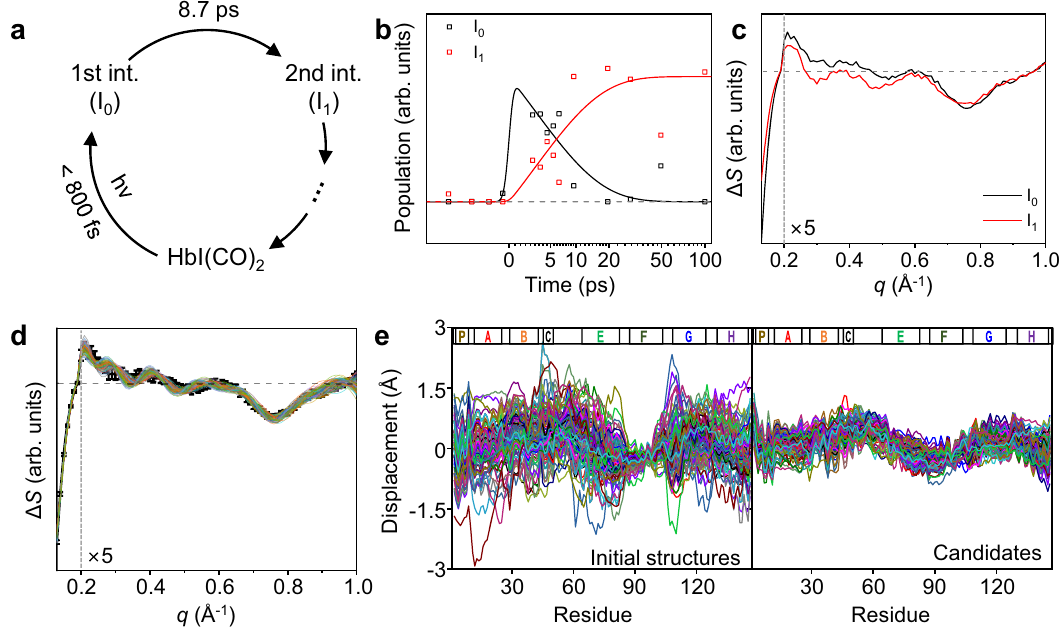
Fig. 2 Kinetic analysis and structure re fi nement for intermediates of HbI. a A kinetic model for the initial response of HbI(CO) 2 upon photoexcitation. The fi rst reaction intermediate (I 0 ) forms within the instrument response function (800 fs) and transforms into the second reaction intermediate (I 1 ) with a time constant of 8.7 ps. b Relative population pro fi les of I 0 and I 1 calculated based on the sequential kinetic model (black and red lines). Optimized populations of each reaction intermediate at each time delay are marked with open squares. c SADSs of I 0 and I 1 . The SADSs were calculated by taking a linear combination of the fi rst and second left singular vectors (lSVs) of SVD results. For clarity, the high q region with q ≥ 0.2 Å − 1 is scaled up by 5. d The SADS of I 0 (black) and the theoretical difference scattering curves of 108 candidates (other colors). For clarity, the high q region with q ≥ 0.2 Å − 1 is scaled up by 5. e Displacement plots of initial structures used for the ERRB structure re fi nement aided by MC simulations (left) and candidate structures obtained from the structure re fi nement (right). For each subunit, the displacement was calculated as the changes in the distance from the iron atom to the C α atom of each residue with respect to the carboxy structure. The displacements of the same residues in the two subunits were averaged. For the displacement plots of the initial structures, 108 initial structures were selected randomly out of the total 270 initial structures used for the structure re fi nement. The labels of the helices are shown at the top of the plots. The helix labels follow the helix identi fi cation in the carboxy structure (PDB entry: